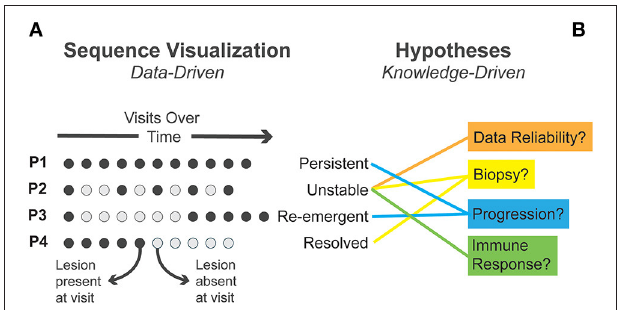
FIGURE 2 | (A) Four exemplary sequence patterns in patient visits identified through visual analysis are presented. Circles represent individual visits with time moving left to right. (B) Several alternative explanatory mechanisms generated during visual analysis are matched to observed